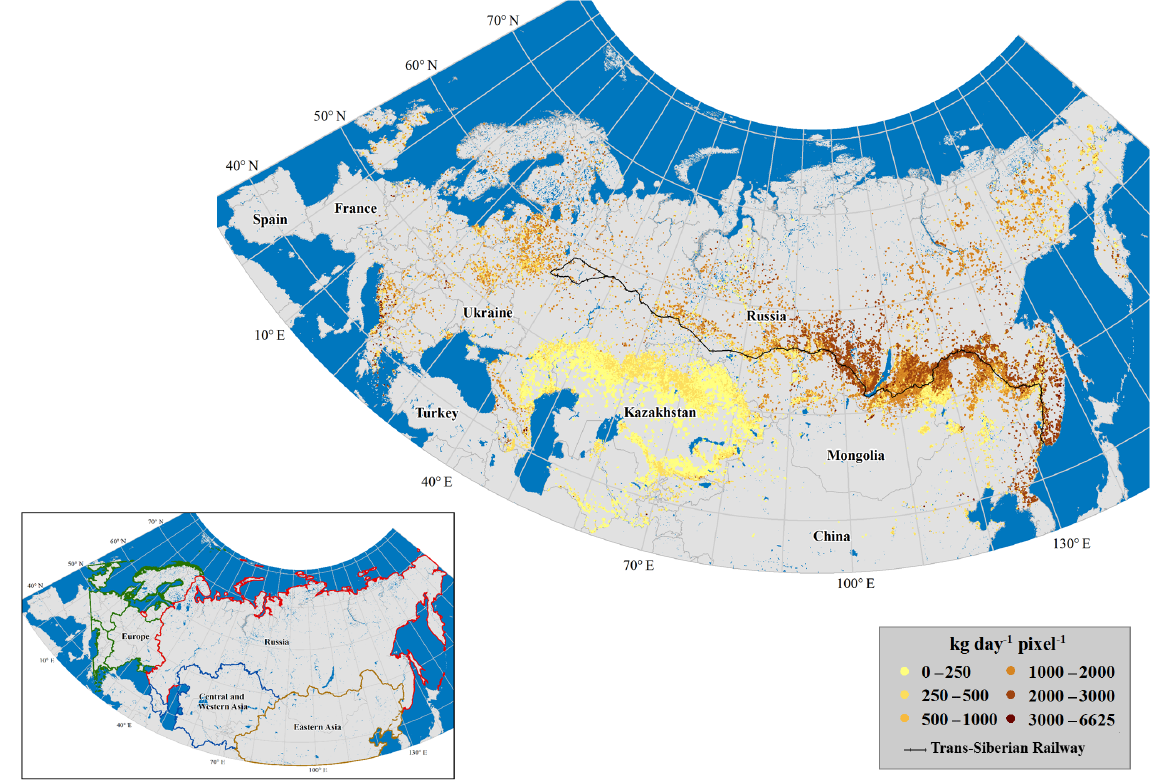
Figure 1. Spatial distribution of BC emissions in northern Eurasia at a 500m × 500m resolution in 2003. The black line illustrates the Trans-Siberian Railway. The inset map is the geographic regions of Russia, eastern Asia, central and western Asia, and